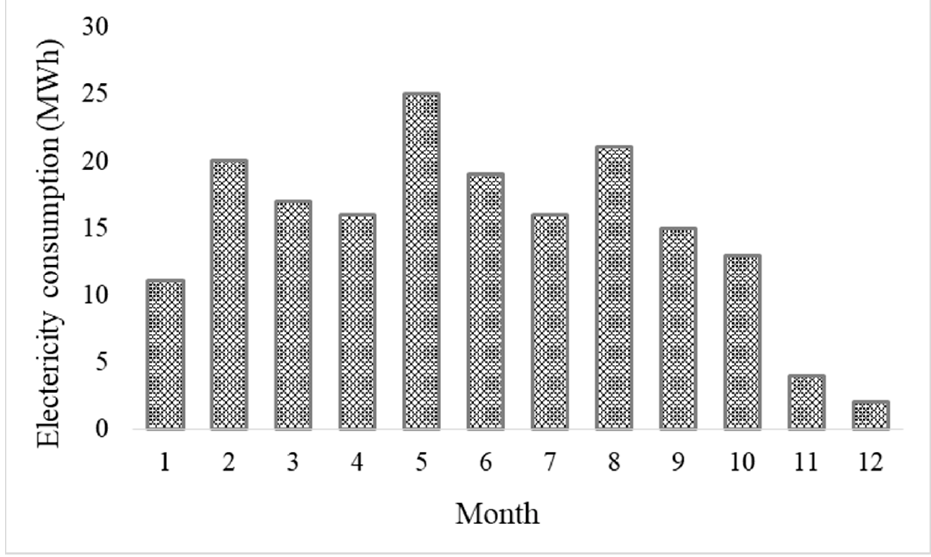
Figure 4. Monthly solar radiation ( a ) and averaged sunshine duration ( b ) of southwest of Taiwan.